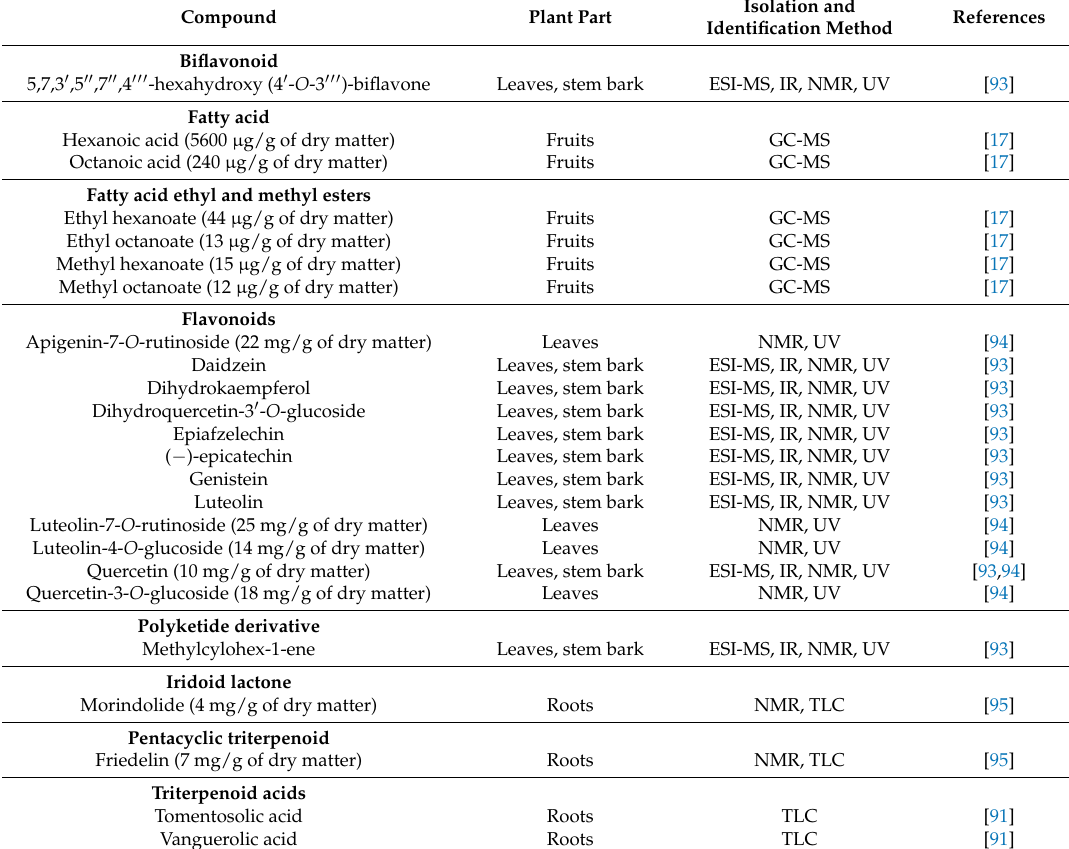
Table 4. Chemical compounds isolated and characterized from Vangueria infausta subsp. infausta